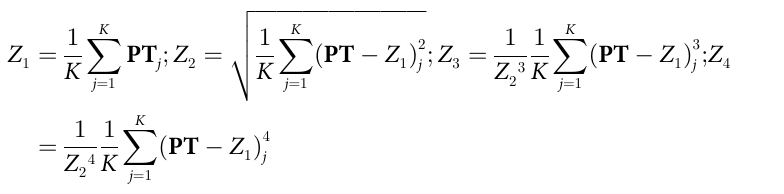
PLOS ONE | https://doi.org/10.1371/journal.pone.0214494 May 16,